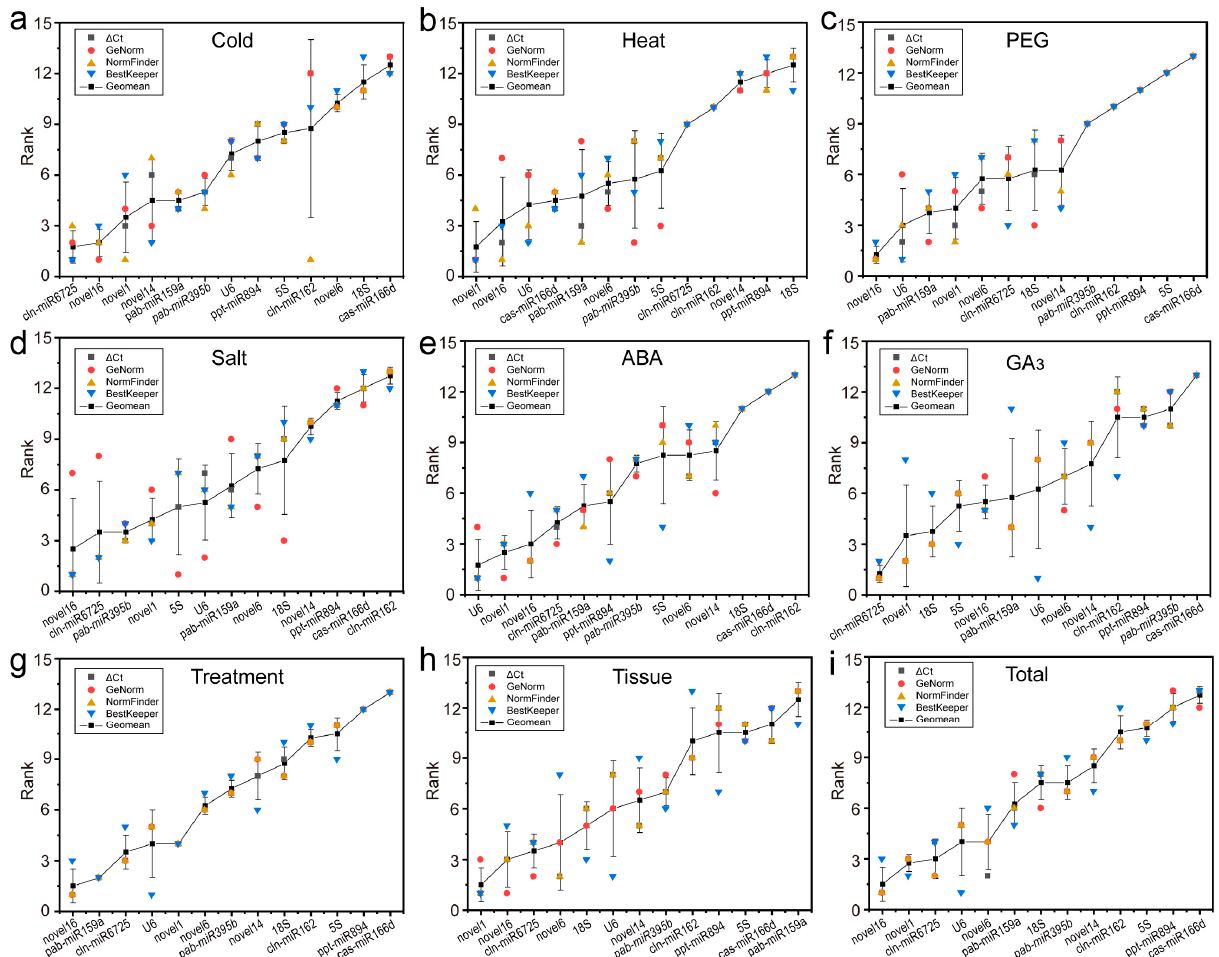
Figure 6. Comprehensive ranking of 13 RGs calculated as the geometric means of four types of rankings. Results from ( a ) 4 °C cold stress; ( b ) 40 °C heat stress; ( c ) drought stress simulated by 15% PEG-6000 treatment; ( d ) salt stress stimulated by 200 mM NaCl treatment; ( e ) 200 μ M ABA treatment; ( f ) 200 μ M GA 3 treatment; ( g ) multiple stresses; ( h ) different tissues (roots, stems, tender needles, cones and seeds); ( i ) total samples.